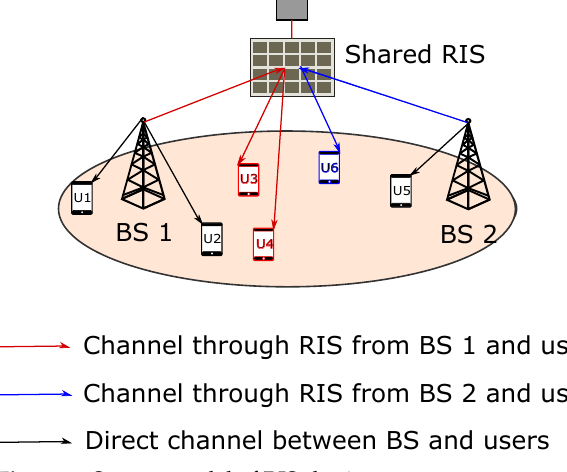
Figure 1. System model of RIS